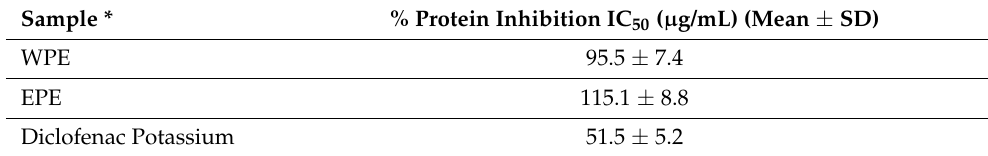
Table 6. Effects of water and ethanolic extract of S. diversifolia on protein denaturation, * ( n =